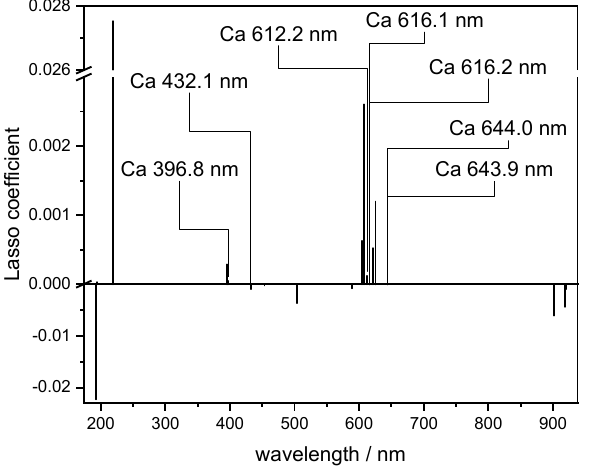
Figure 8. Lasso coe ffi cients for Ca Figure 8. Lasso coefficients for Ca regression.